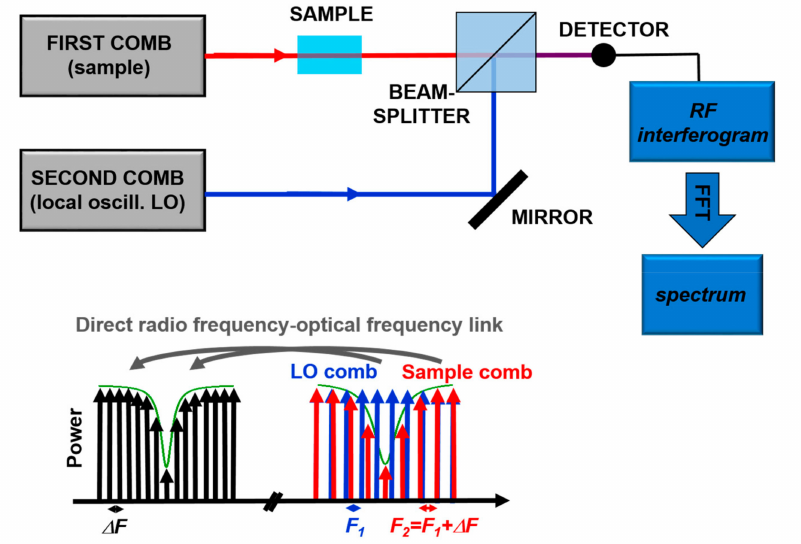
Figure 7. Principles of Dual-Comb Spectroscopy. Adapted with permission from [70], copyright 2014.